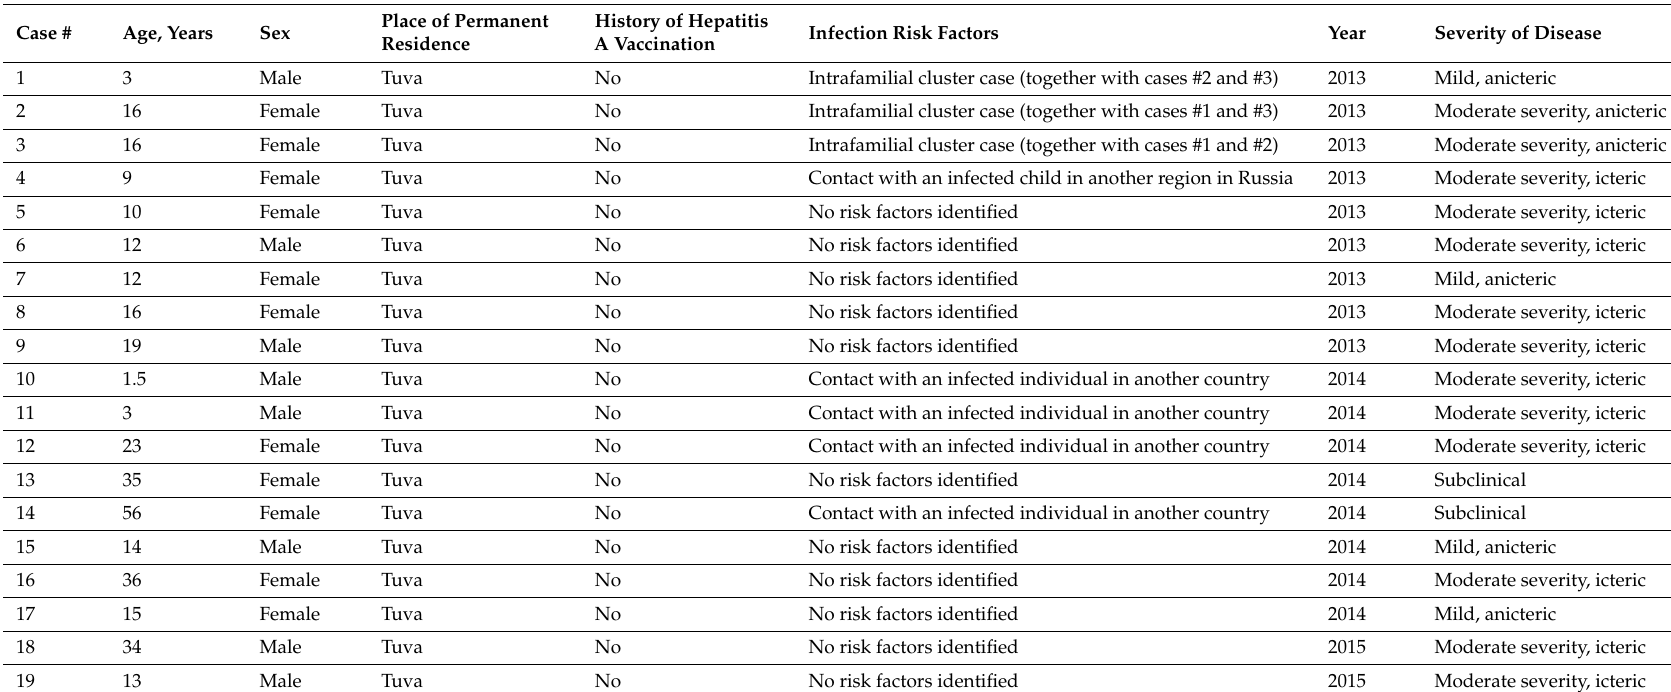
Table 1. Cases of hepatitis A reported in Tuva,